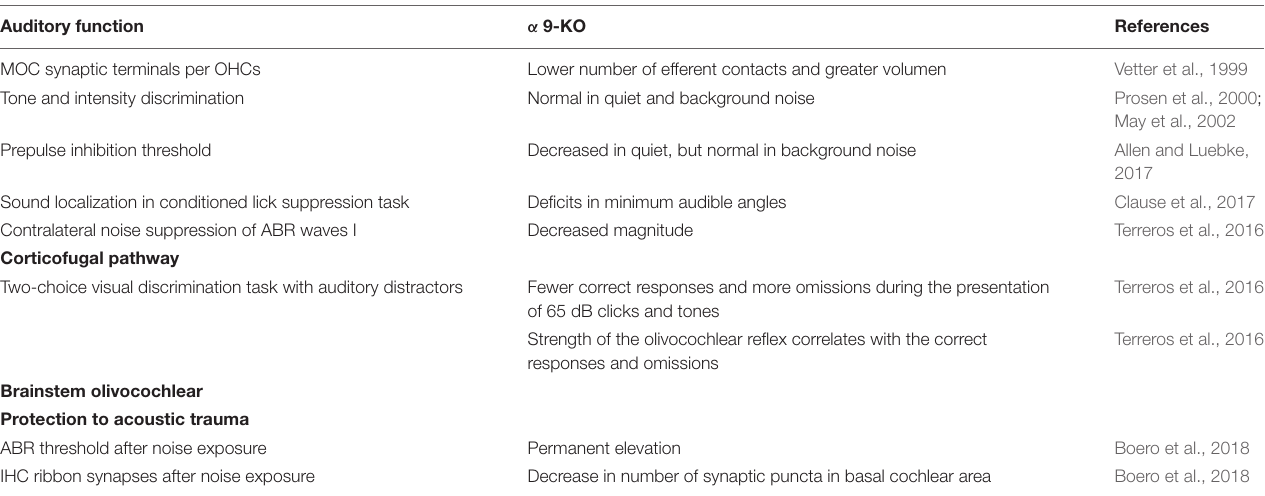
TABLE 1 | Overview of auditory studies in α